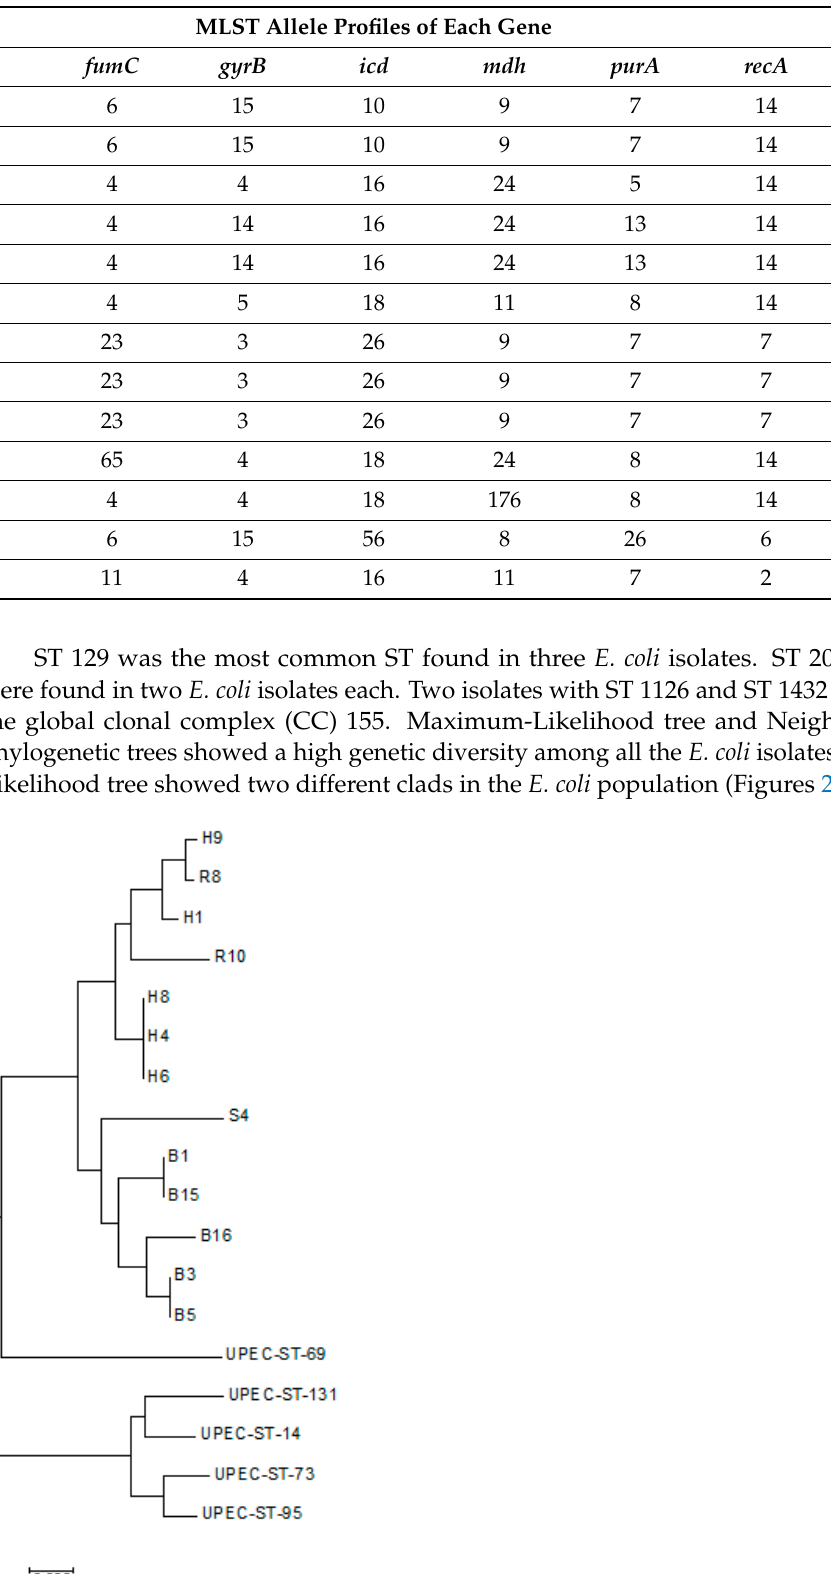
Table 2. MLST profile of 13 E. coli isolates.